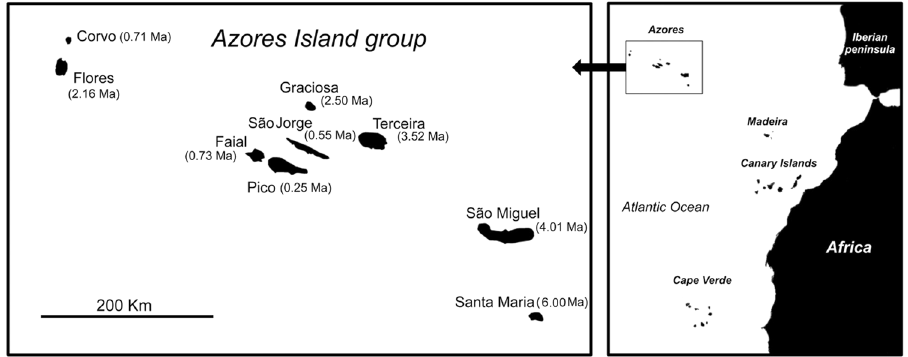
Figure 2. The Azorean archipelago. Maximum sub-areal dates for each island are in million of years (Ma) 29 . Maps were generated with Map data: Google, DigitalGlobe and modified using Adobe Illustrator CS3 13.0 and Adobe Photoshop CS 8.0 (Adobe Systems